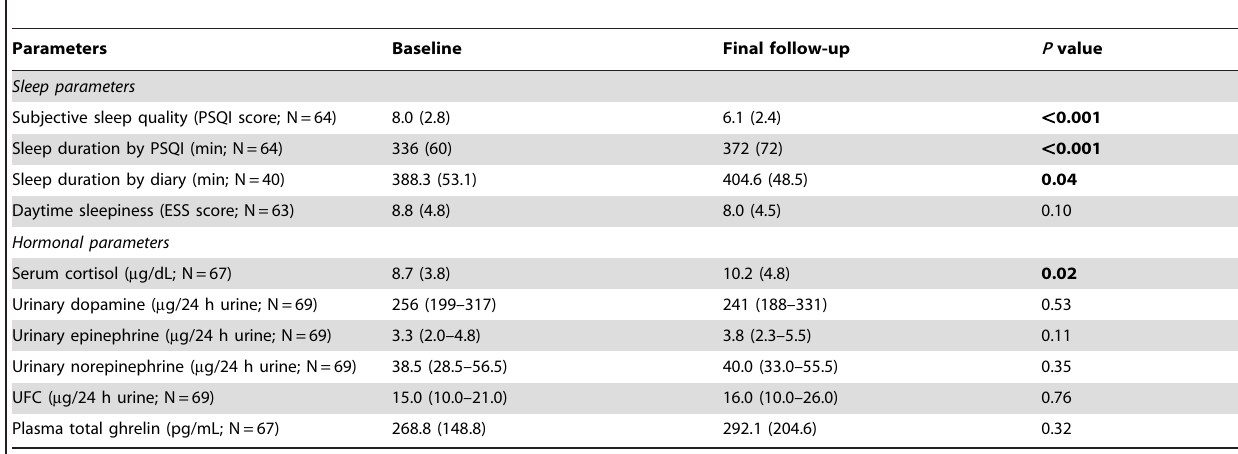
Table 3. Changes in sleep and hormonal parameters between the baseline and final follow up evaluation.